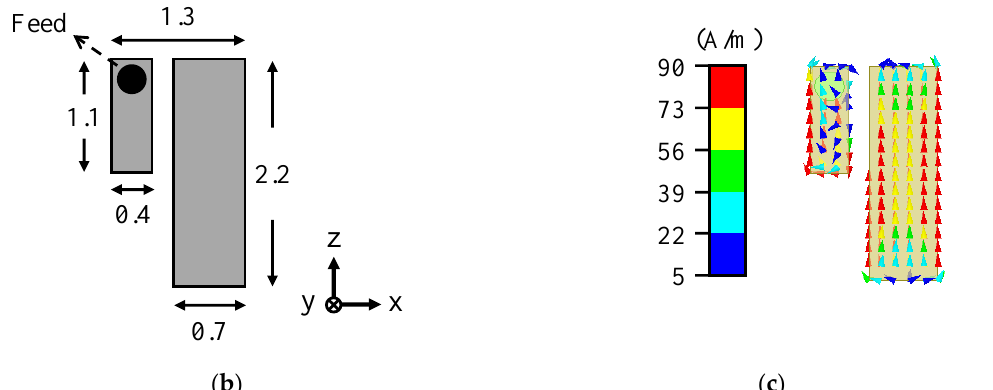
Figure 3. Geometry of ( a ) the 38 GHz 1 × 8 coupled patch antenna array and ( b ) the unit element (all measurements are in mm). ( c ) The surface current distributions at 38 GHz.